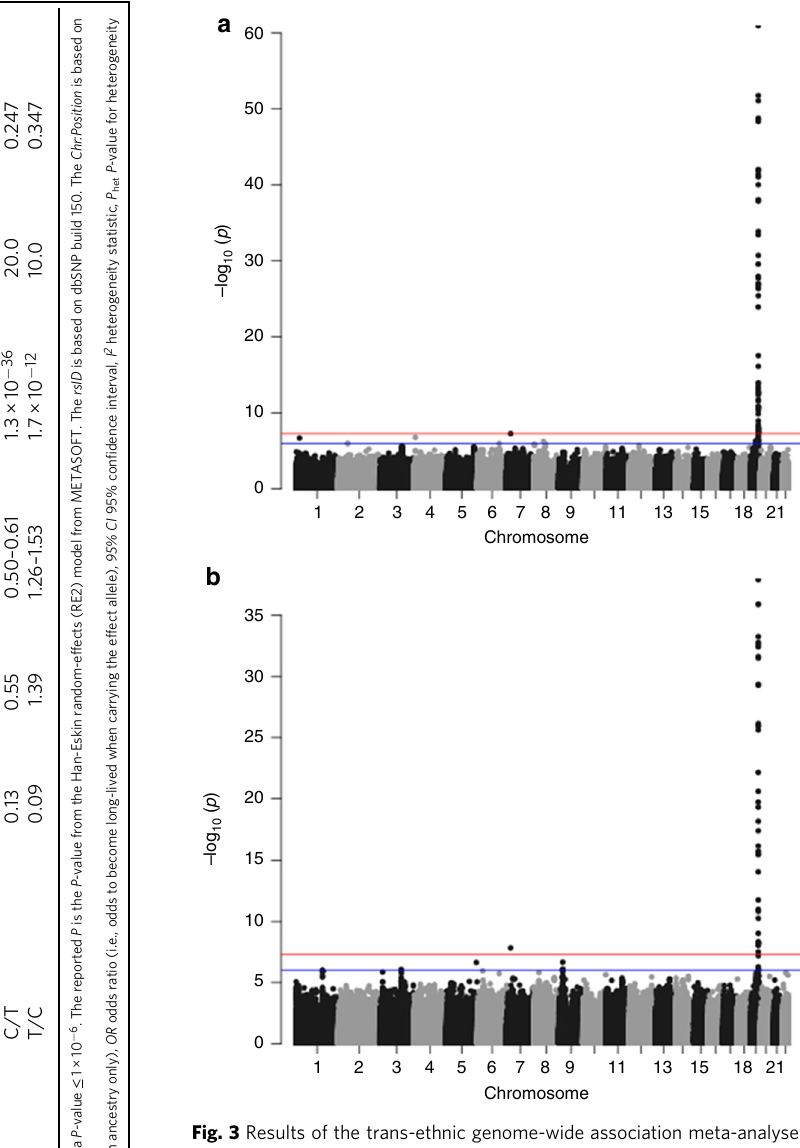
Fig. 3 Results of the trans-ethnic genome-wide association meta-analyses. Manhattan plot presenting the – log 10 P -values from the trans-ethnic genome-wide association meta-analysis of the 90th percentile cases versus all controls ( a ) and 99th percentile cases versus all controls ( b ). The red line indicates the threshold for genome-wide signi fi cance ( P ≤ 5 × 10 − 8 ), while the blue line indicates the threshold for genetic variants that showed a suggestive signi fi cant association ( P ≤ 1 × 10 − 6